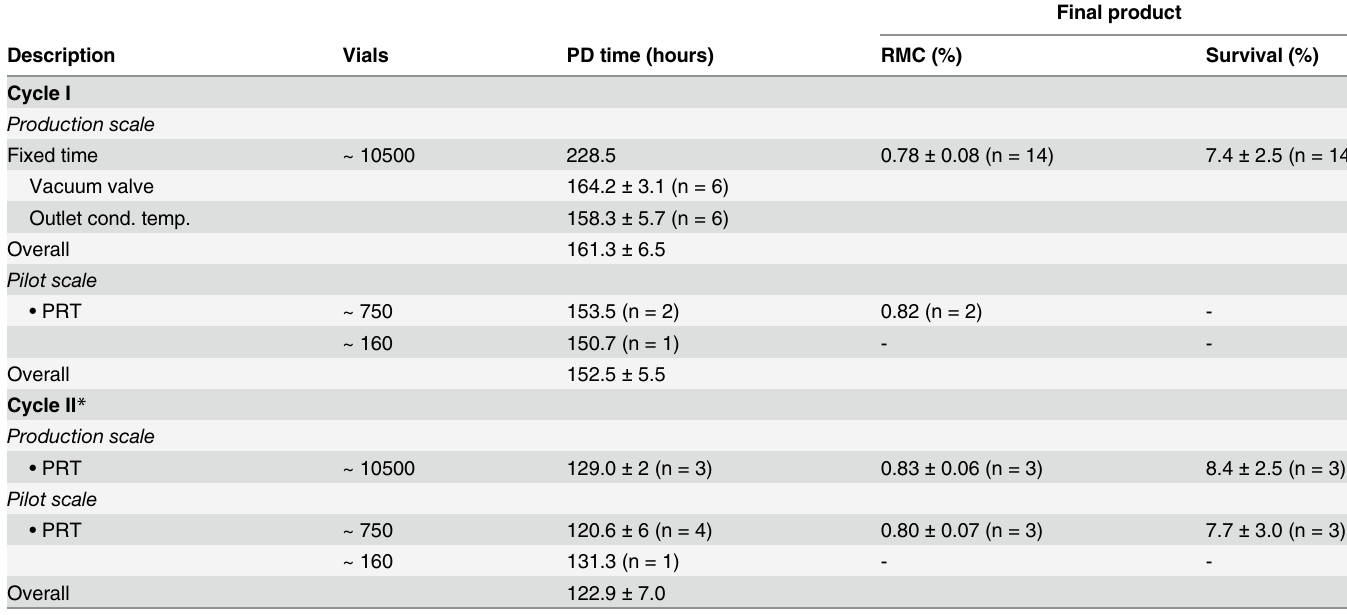
Table 3. Overview of primary time (hours), RMC (%), and BCG survival rate (%) as a function of the freeze-drying cycle and freeze-dryer scale. Sev- eral methods were used for primary drying endpoint determination: the vacuum valve open/close frequency, the outlet condenser temperature, and PRT refers to the pressure rise test. The maximum load of the freeze-dryers is as follows: 12500 vials at production scale and 750 vials at pilot scale. See S1 Data for raw